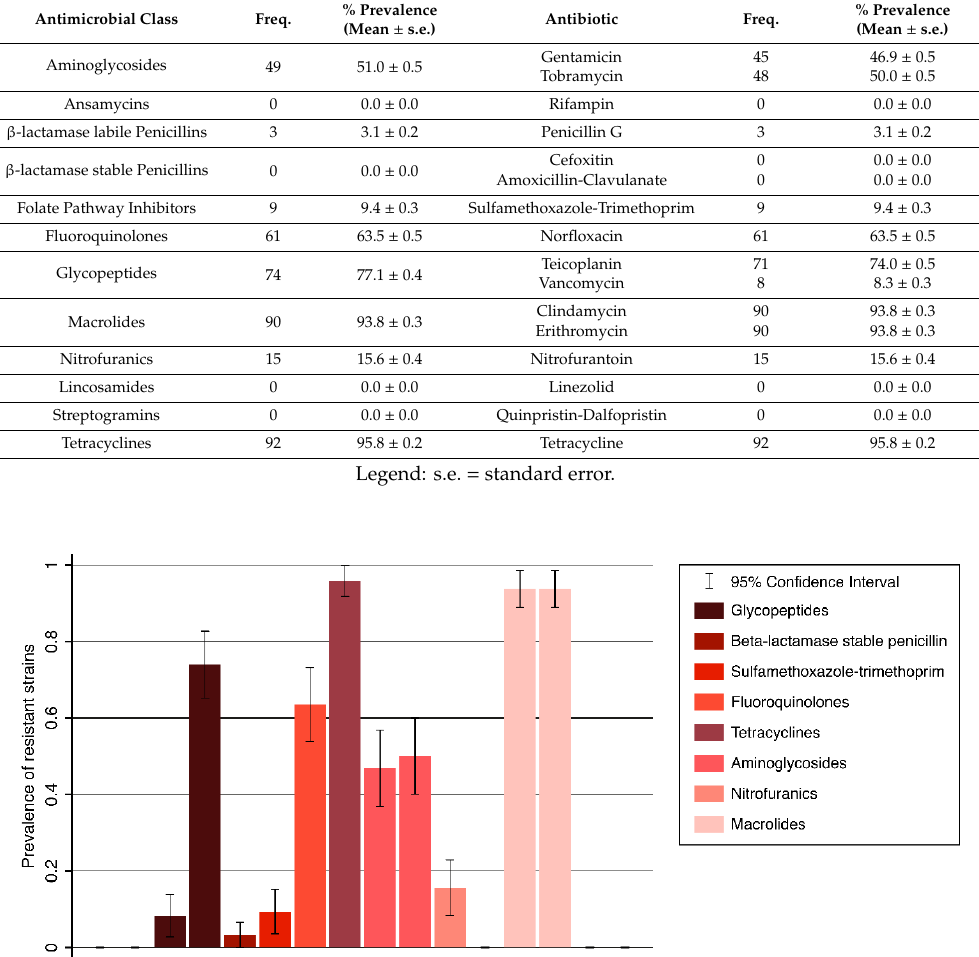
Table 2. Spa types associated to resistance profiles and pathotypes and their relative frequencies. All